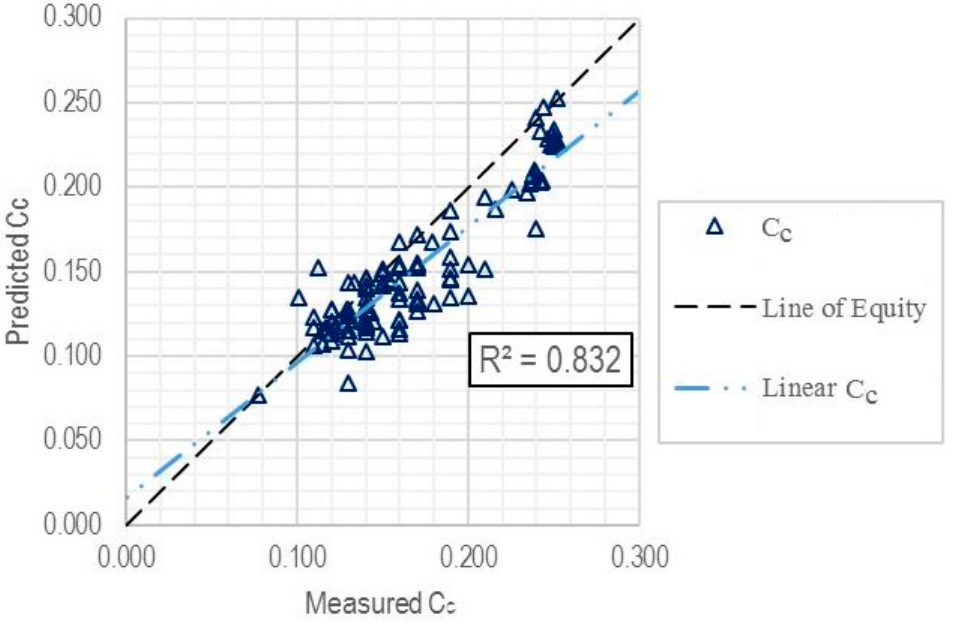
Figure 8. Predicted versus measured C c for the entire dataset (training + validation). Table 3. Model performance. RMSE: root mean squared error; MAE: mean average error. Set